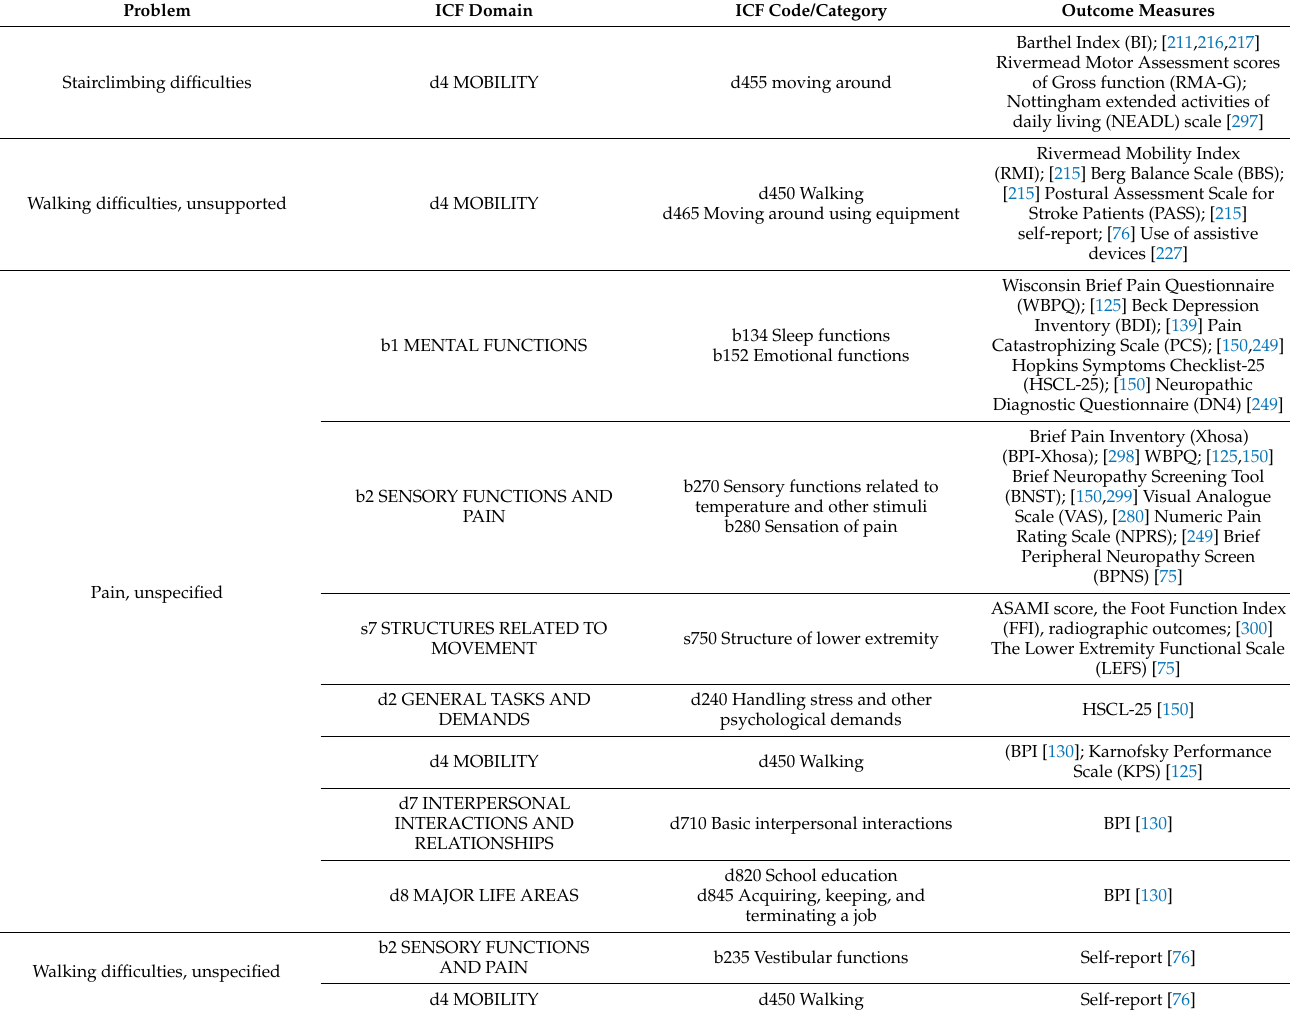
Table 2. Mapping of top 20 presenting functioning problems to the ICF according to related outcome